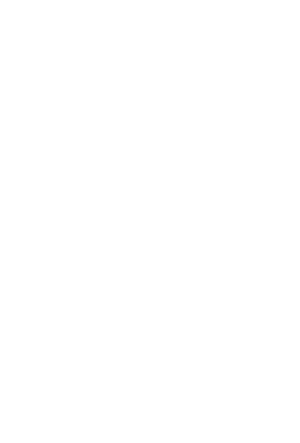
FIGURE 3 | Boxplots comparing differences of posterior probabilities between 1p/19q co-deletion and non-codeletion